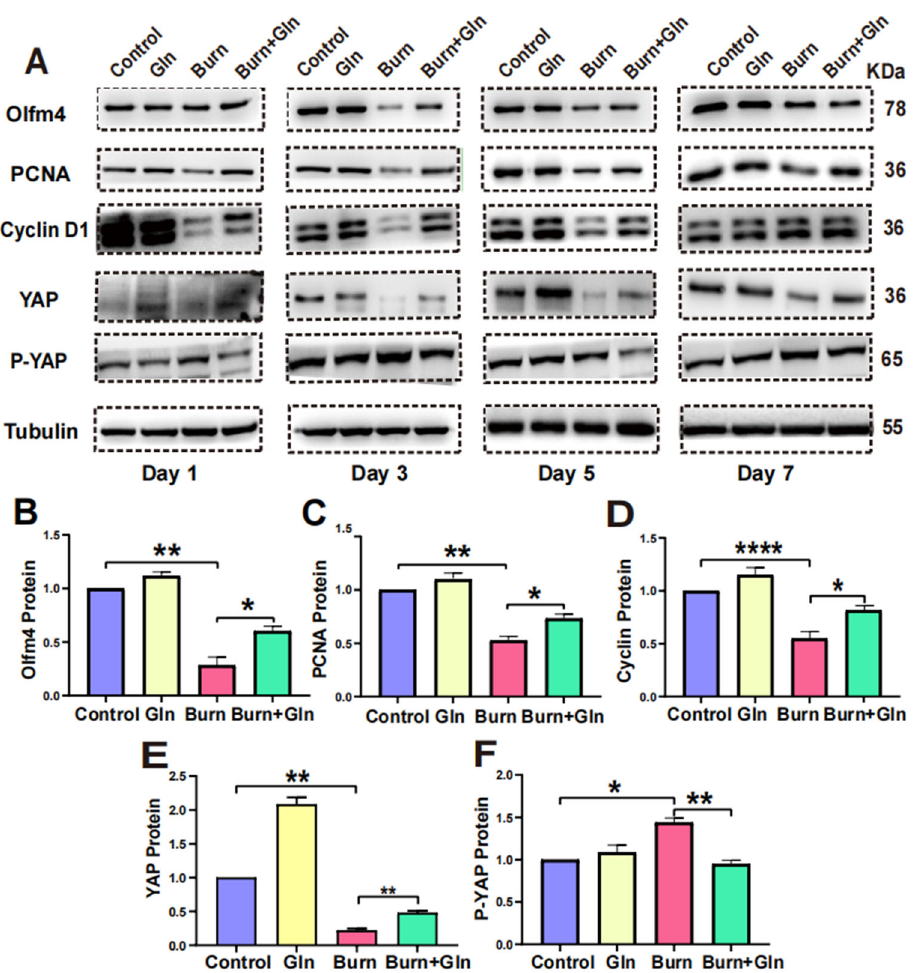
Figure 8. Gln promotes proliferation by activating the YAP-Hippo signaling pathway. ( A ) Protein abundances in crypts from C57 mice of Olfm4, PCNA, Cyclin D1, YAP, and p-Yes-associated Protein (p-YAP) were measured by immunoblotting using antibodies in small intestinal stem cell tissue treated with Gln after burn ( n = 6). ( B ) Quantification of Olfm4 protein expression in crypts from C57 mice on Day 3. ( C ) Representative immunoblot analysis of PCNA in treated Gln. ( D ) Quantification of Cyclin D1 protein expression in crypts from C57 mice on Day 3. ( E ) Quantification of YAP expression in crypts from C57 mice on Day 3. ( F ) Quantification of p-YAP expression in crypts from C57 mice on Day3. Data were expressed as Mean ± SEM from 6 independent experiments ( n = 6). * p < 0.1, ** p < 0.01, **** p < 0.0001 using 1-way ANOVA and post hoc Tukey’s